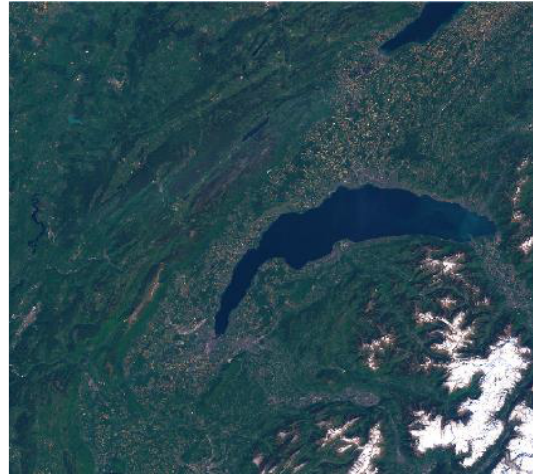
Figure 3. RGB image from Sentinel-2